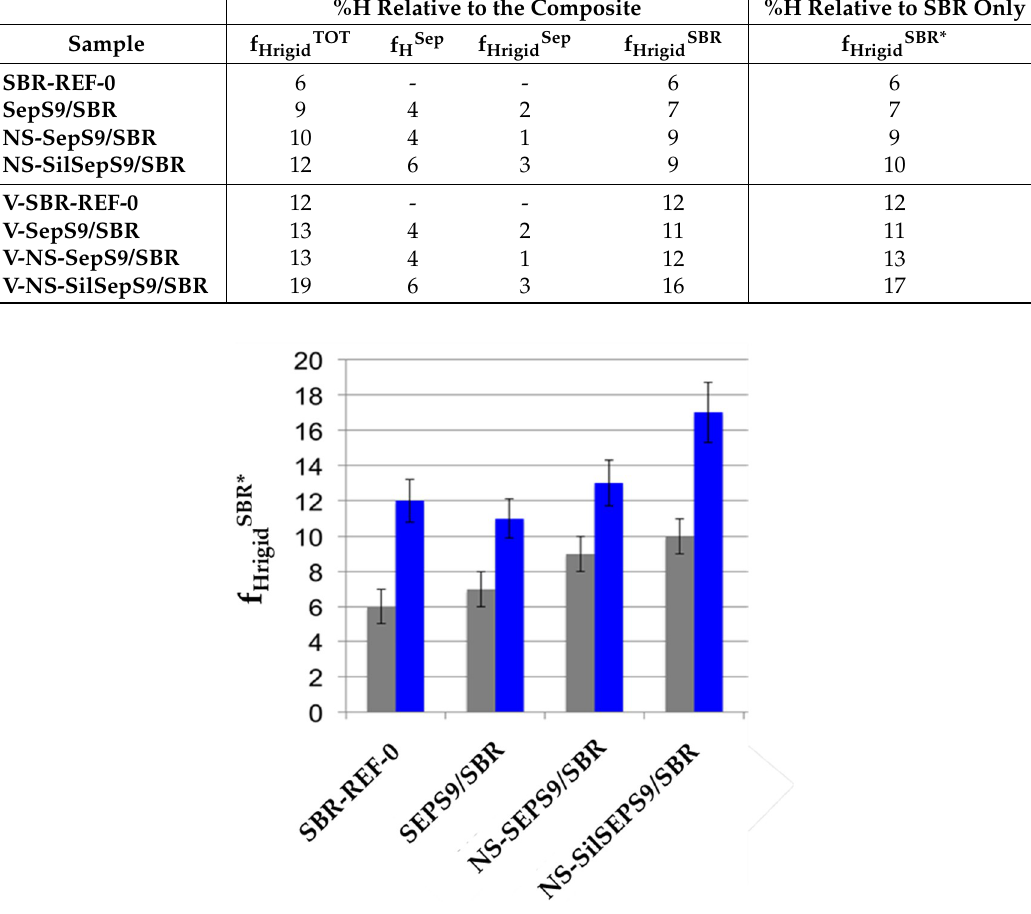
Figure 5. Fraction of rigid rubber (f HrigidSBR* , %) determined for the uncured (grey) and vulcanized (blue) samples from the analysis of 1 H FID’s, as described in the text.